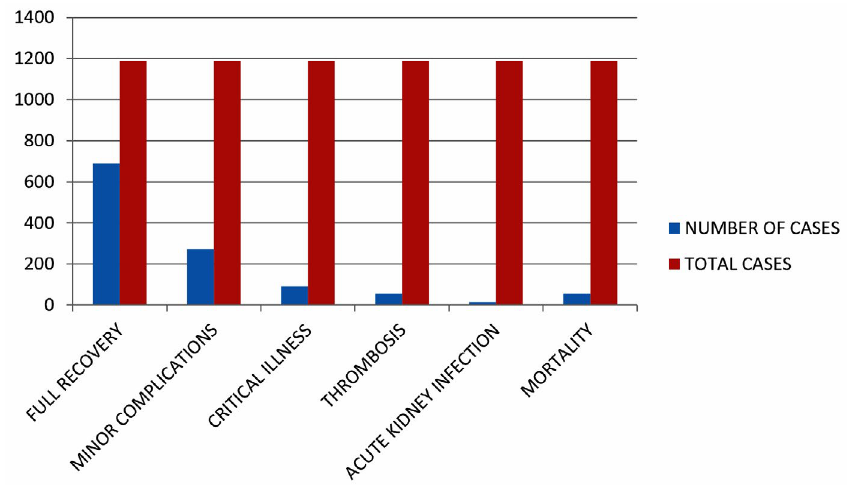
Fig. 2. Chart showing clinical results in patients with abnormal